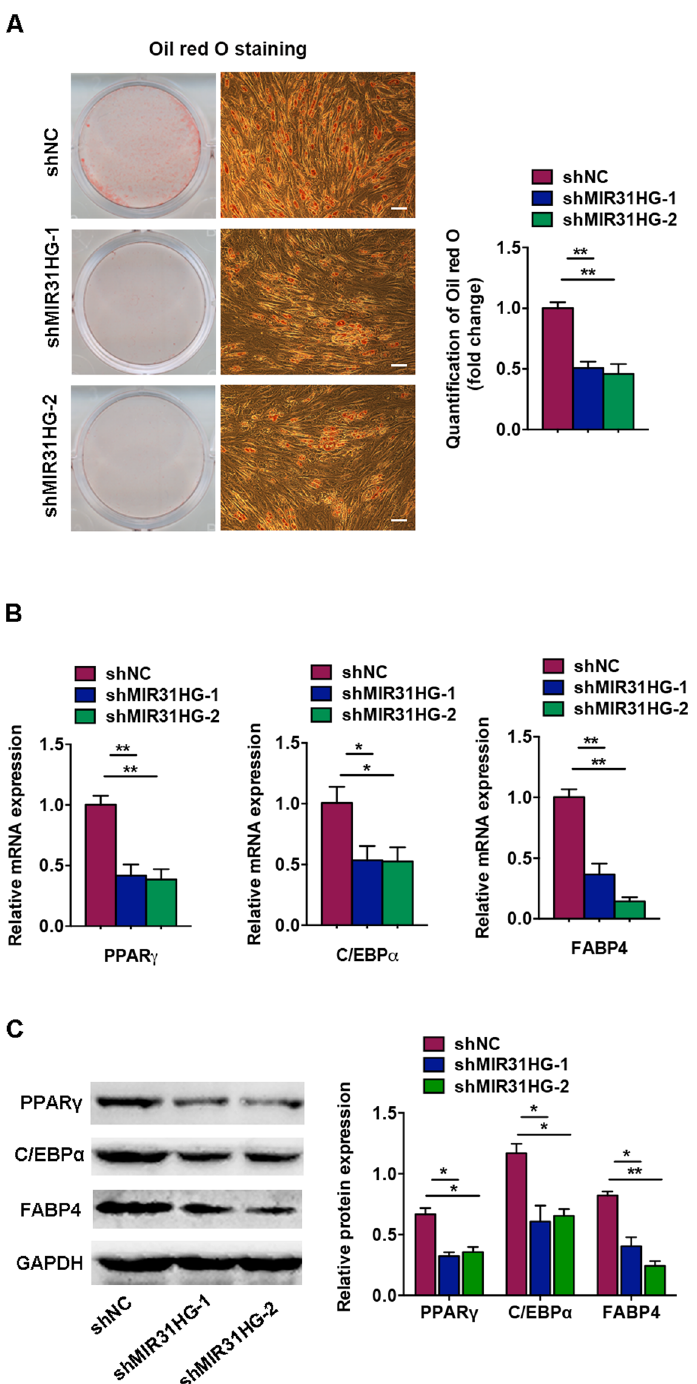
Figure 4. Knockdown of MIR31HG inhibited adipogenic differentiation. The hASCs were transfected with lentivirus expressing sh MIR31HG-1 , sh MIR31HG-2 , or the scrambled nontargeting vector (shNC). ( A ) Images of Oil red O staining on day 8 of adipocyte differentiation. Scale bar, 100 μ m. Histograms show quantification of Oil red O staining by spectrophotometry (normalized to shNC group). ( B ) Relative mRNA expression of the adipogenic factors PPAR γ , C/EBP α , and FABP4 measured by qRT-PCR on day 4 of adipogenic induction. ( C ) Western blot analysis of PPAR γ , C/EBP α , FABP4, and GAPDH on day 4 of adipogenic induction. Histograms show quantification of the band intensities. Results are presented as mean ± SD ( * P < 0.05, ** P <